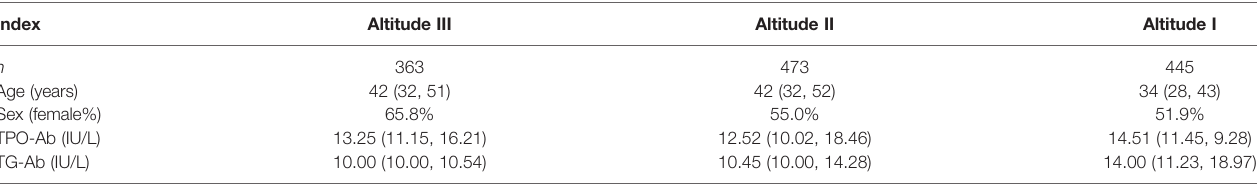
TABLE 1 | Baseline information of individuals enrolled in this study.